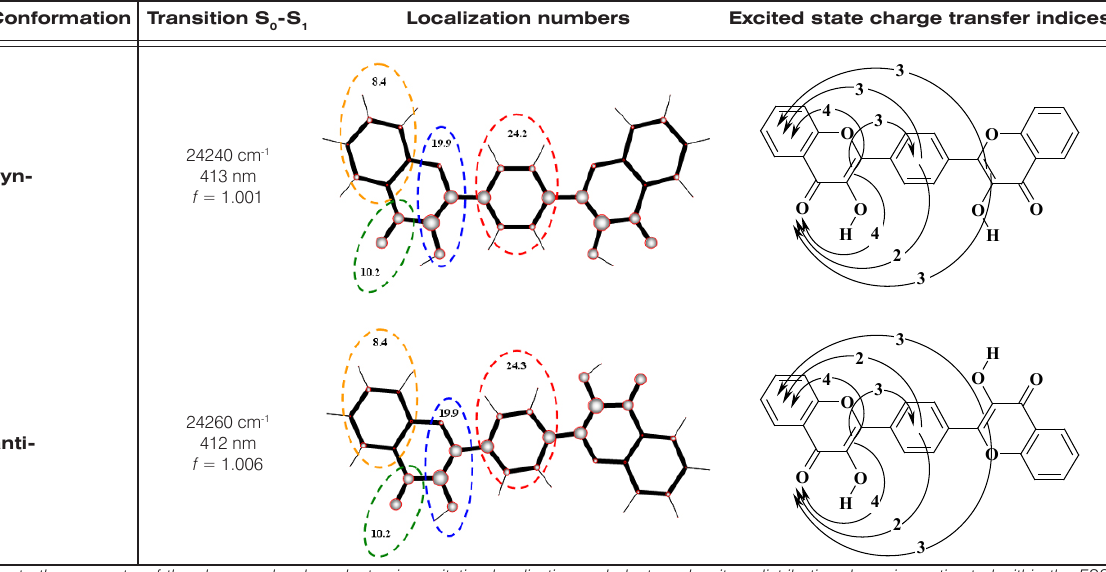
Table 1. Characteristics of the long-wavelength electronic transitions in the molecules of syn- and anti- conformers of bis -flavonol. Con for ma tion Transition S